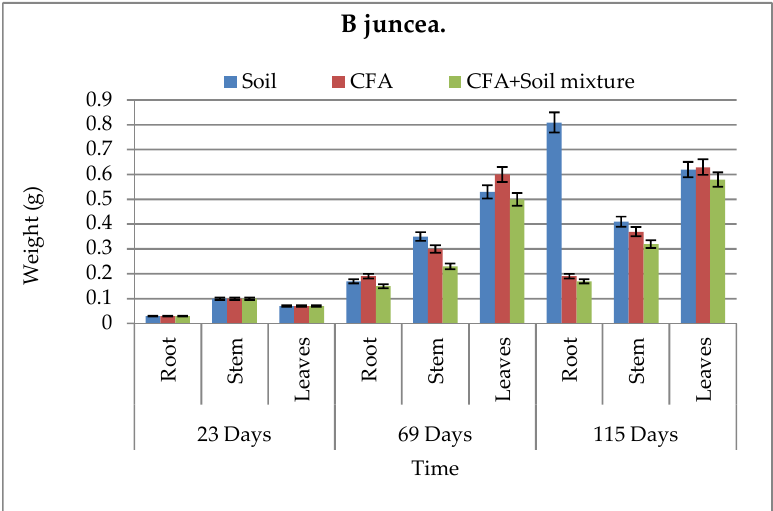
Figure 4. Above- and below-ground biomass for B. juncea in all growth media. CFA: Coal-fly-ash.